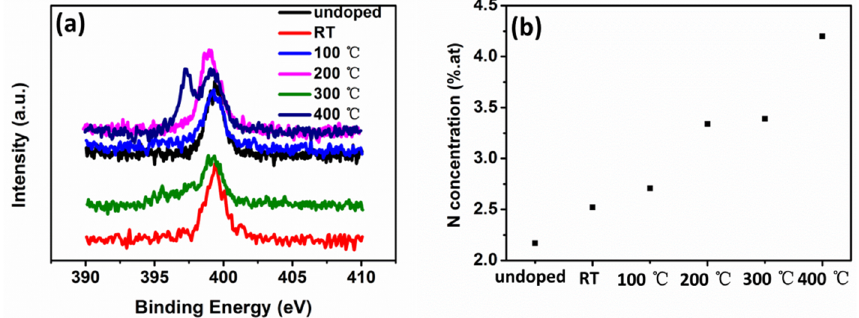
Figure 7. ( a ) N 1 s spectra of NiO thin films and ( b ) N content as a function of substrate temperature. The color of N-doped NiO thin films transformed from semitransparent grey to opaque dark brown